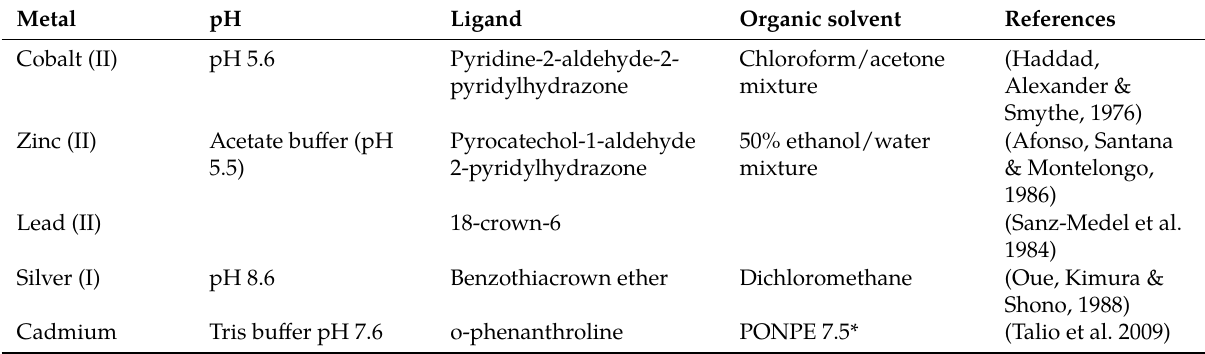
Table 3: Extractive spectrofluorimetric methods for some heavy metals through ternary complex formation with eosin Y and ligands other than